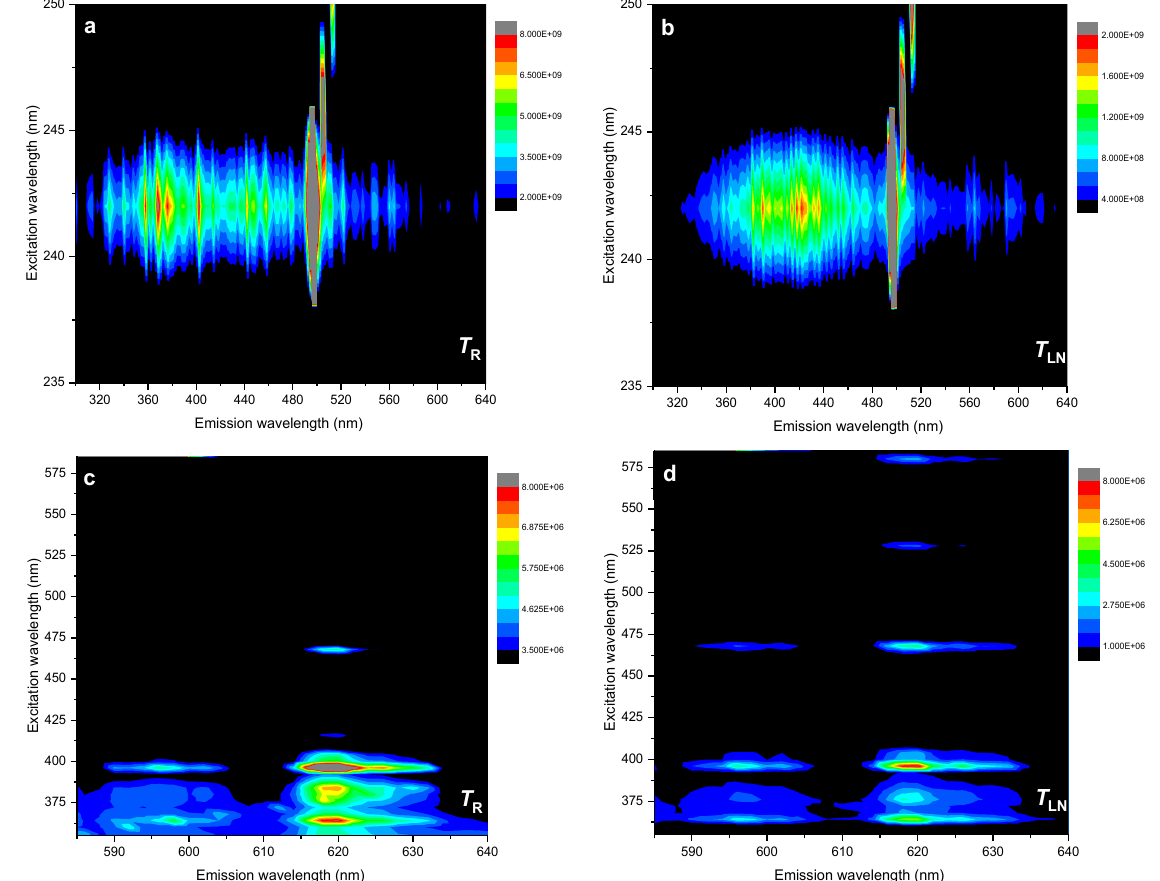
Fig. 10 PL spectra of Eu-doped MgGa 2 O 4 :Mn 2+ ceramics recorded at (a, c) room temperature and (b, d) LN